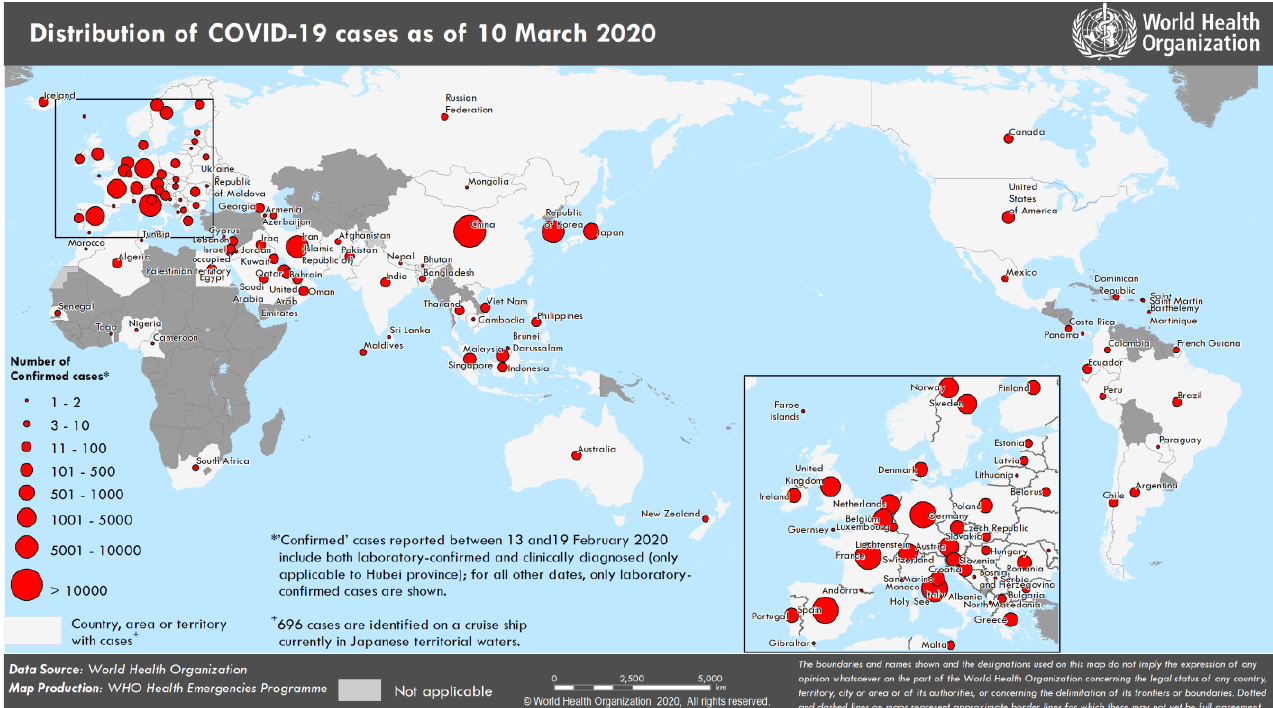
Figure 1. Countries, territories or areas with reported confirmed cases of COVID-19, 10 March